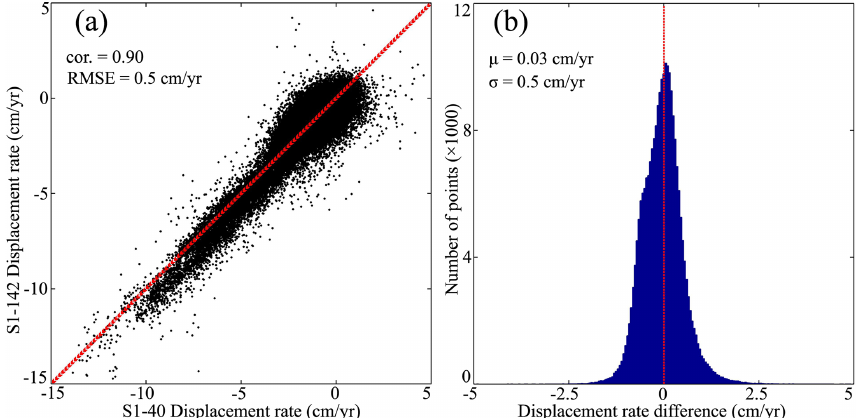
Figure 4. The cross-validation of InSAR results from S1-40 and S1-142. The correlation and the difference between the two measurements are shown in (a) and (b) ,